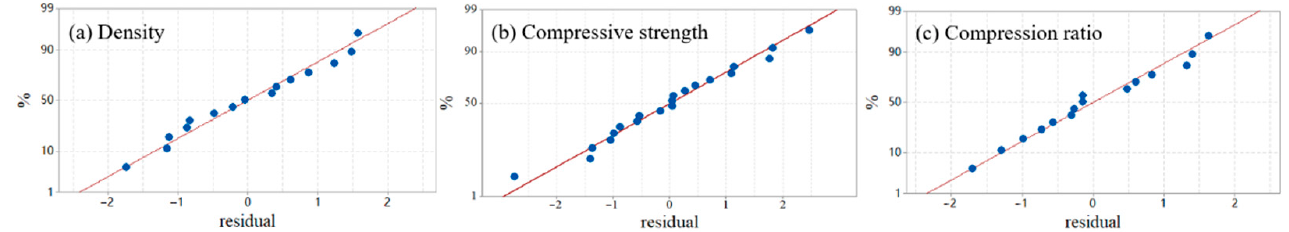
Figure 9. Normal Probability Plot for process parameters: ( a ) Density; ( b ) Compressive strength; ( c ) Compression ratio. Table 5. ANOVA results of CCDs experiments.